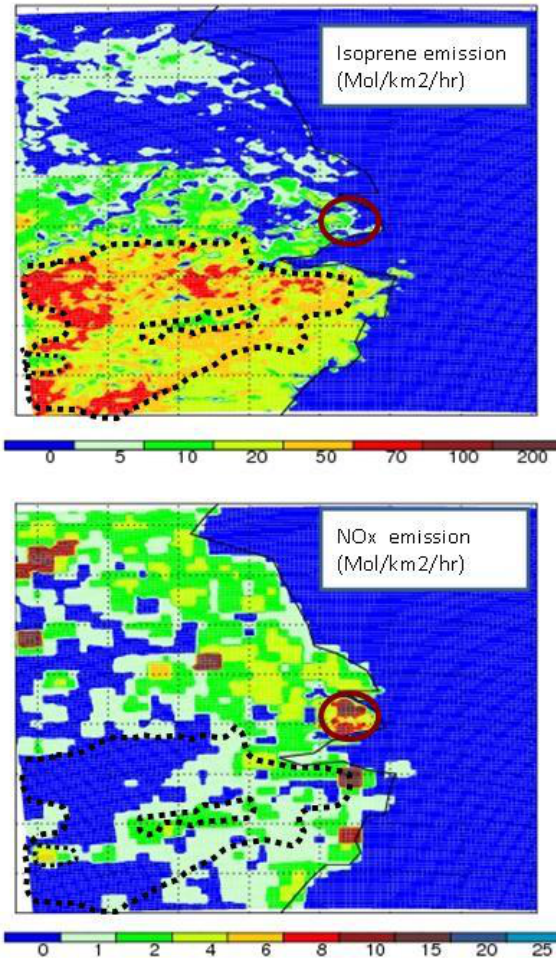
Fig. 4. Biogenic isoprene emissions in the forests calculated by the Figure 4, Biogenic isoprene emissions in the forests calculated by the MEGAN model (upper panel), and anthropogenic NO x emissions MEGAN model (upper panel), and anthropogenic NOx emissions based based on the inventory in the WRF-Chem model (Tie et al., 2009). on the inventory in the WRF-Chem model (Tie et al., 2009). The The dash-lines highlight the highest isoprene emission dash-lines highlight the highest isoprene emission area.